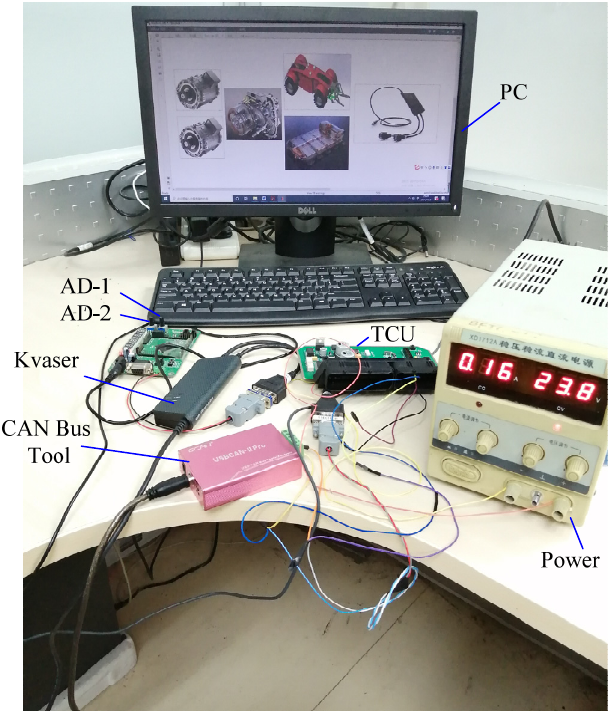
Figure 9. Hardware-in-loop test bench.